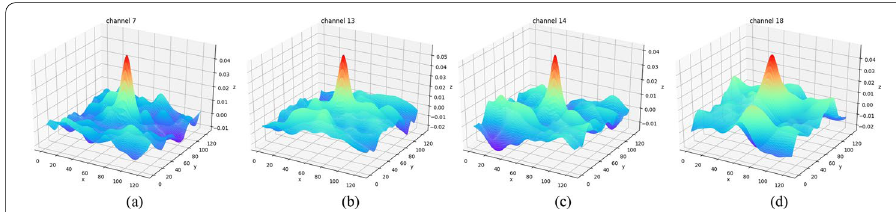
Fig. 2 Typical channel output response. a The output response of channel 7; b The output response of channel 13; c The output response of channel 14; d The output response of channel